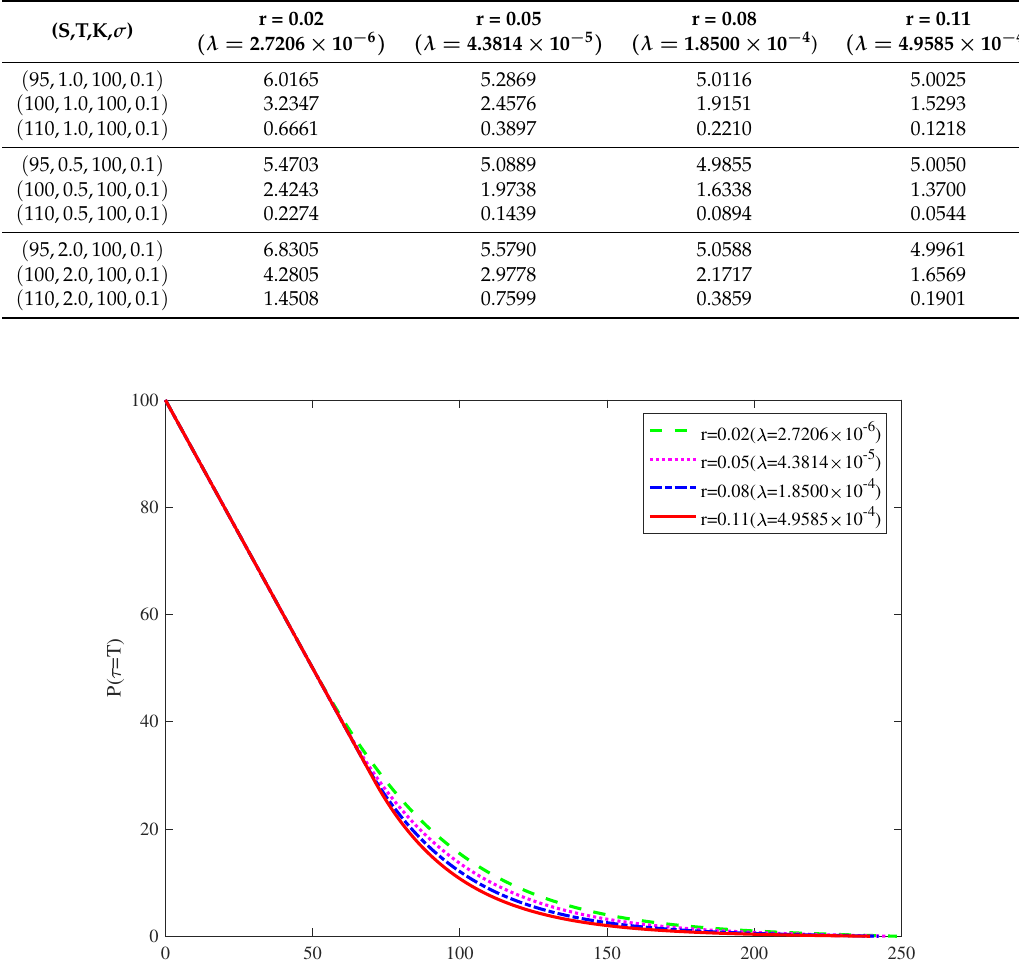
Table 1. American put option values.